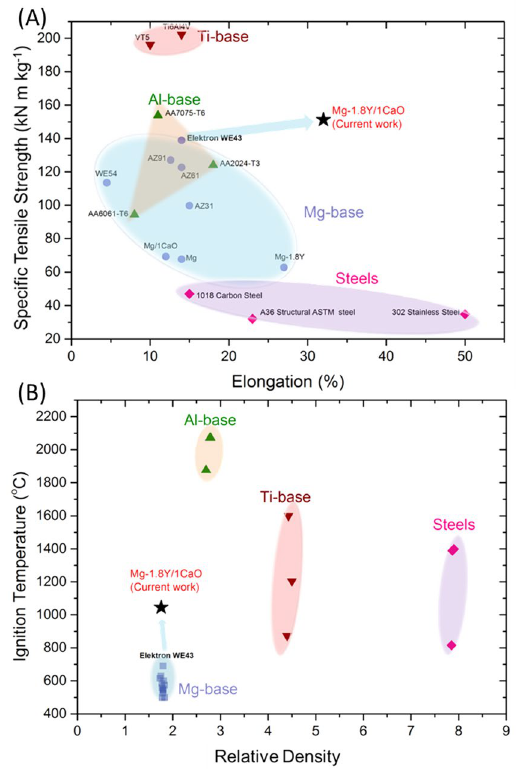
Figure 1. Holistic properties constituting specific strength-ductility-ignition temperature of the Mg-1.8Y/1CaO nanocomposite in comparison to the commercially available alloys. ( A ) Density normalized tensile yield strength versus elongation to failure of nanocomposite in the current work compared with commercially used alloys in aerospace applications; (B) An overview of the ignition properties and relative density of the commercial metallic materials. Ignition temperature versus relative density of commercial Mg-base alloys (AZ31, AZ91, Elektron WE43), commercial Al-base alloys (AA2024, AA6061 and AA7075), commercial Ti-base alloys (Ti6Al4V,